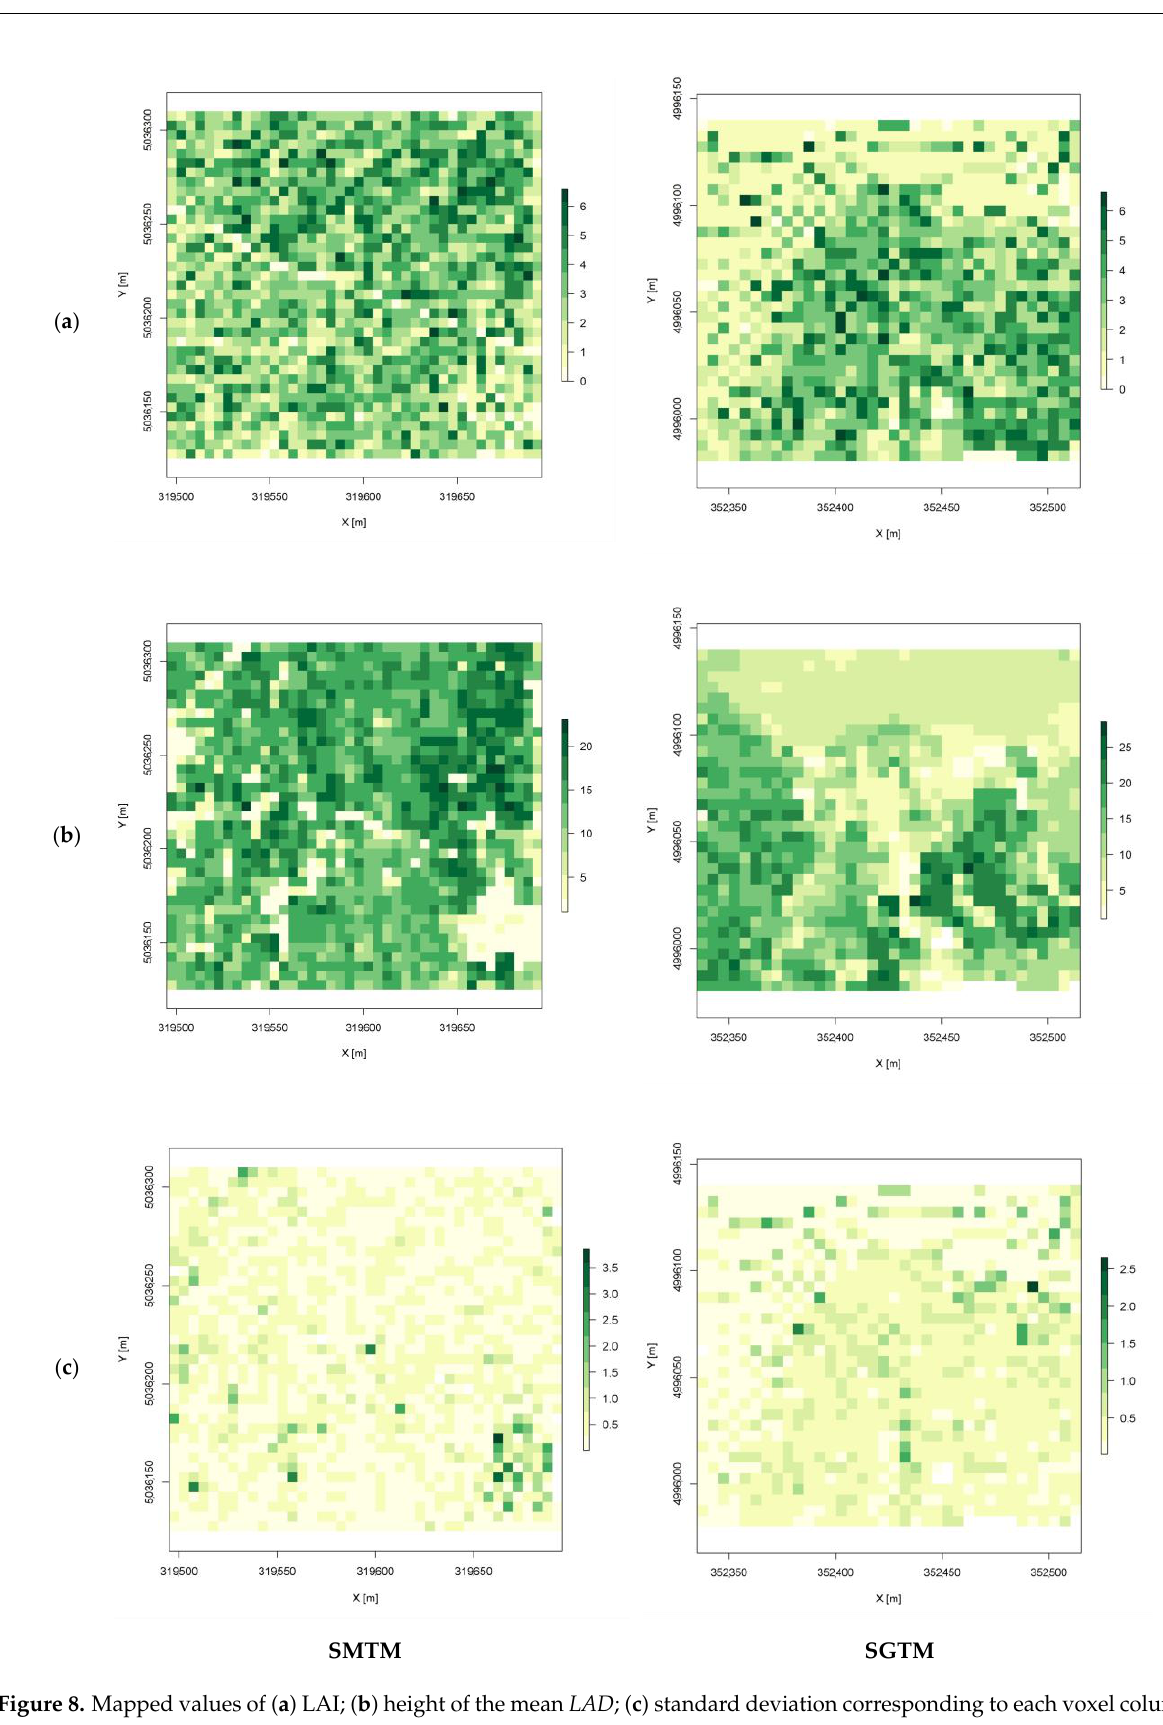
Figure 8. Mapped values of ( a ) LAI; ( b ) height of the mean LAD ; ( c ) standard deviation corresponding to each voxel